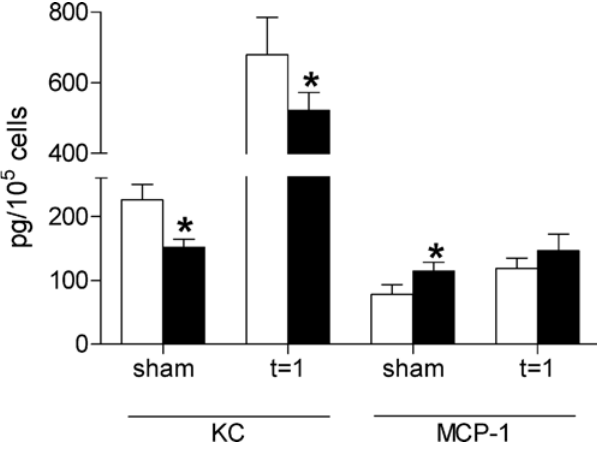
Figure 3. Renal influx of granulocytes in wild type and TLR4 2 / 2 mice. Influx of granulocytes in kidneys from wild type (white bars) and TLR4 2 / 2 (black bars) kidneys 1, 5 and 10 days after renal I/R injury or sham operation. One and ten days after I/R injury the number of granulocytes was significantly lower in kidneys of TLR4 2 / 2 mice than in kidneys of wild type mice as counted in 10 randomly selected high- power fields (HPFs) on outer medulla (magnification 6 400). The amount of granulocytes from 8 mice per group were counted on renal tissue sections stained for Ly-6G and presented as mean 6 SEM. * p , 0.05.